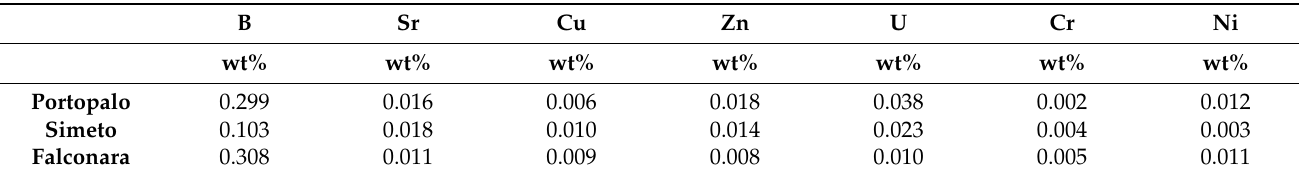
Table 2. Averages of the mass percentages of the trace elements in the biocement sampled in summer 2021 at the three sites.